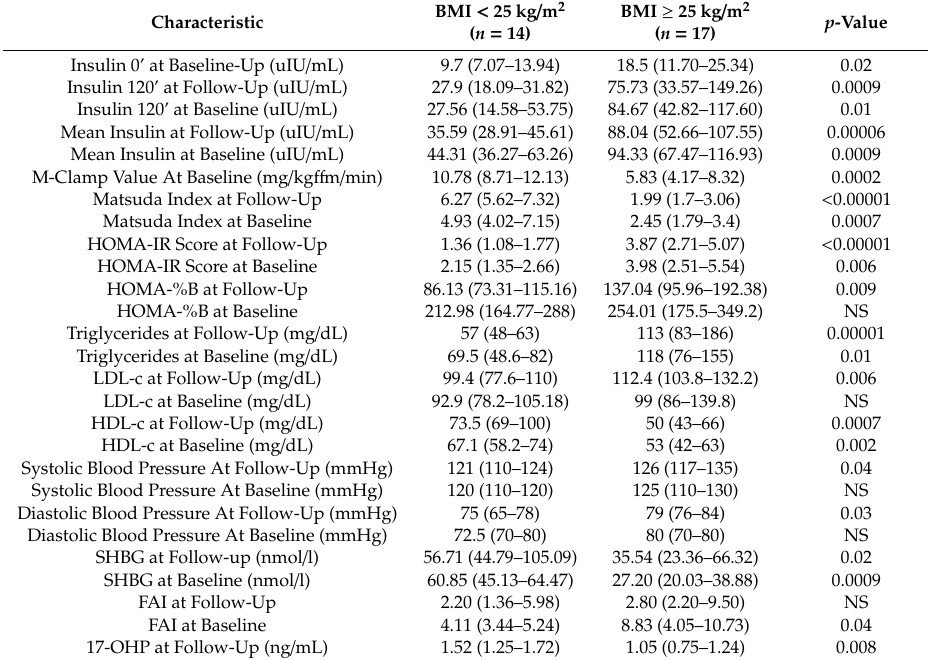
Table 3. Correlations between final and baseline anthropometric and metabolic parameters.